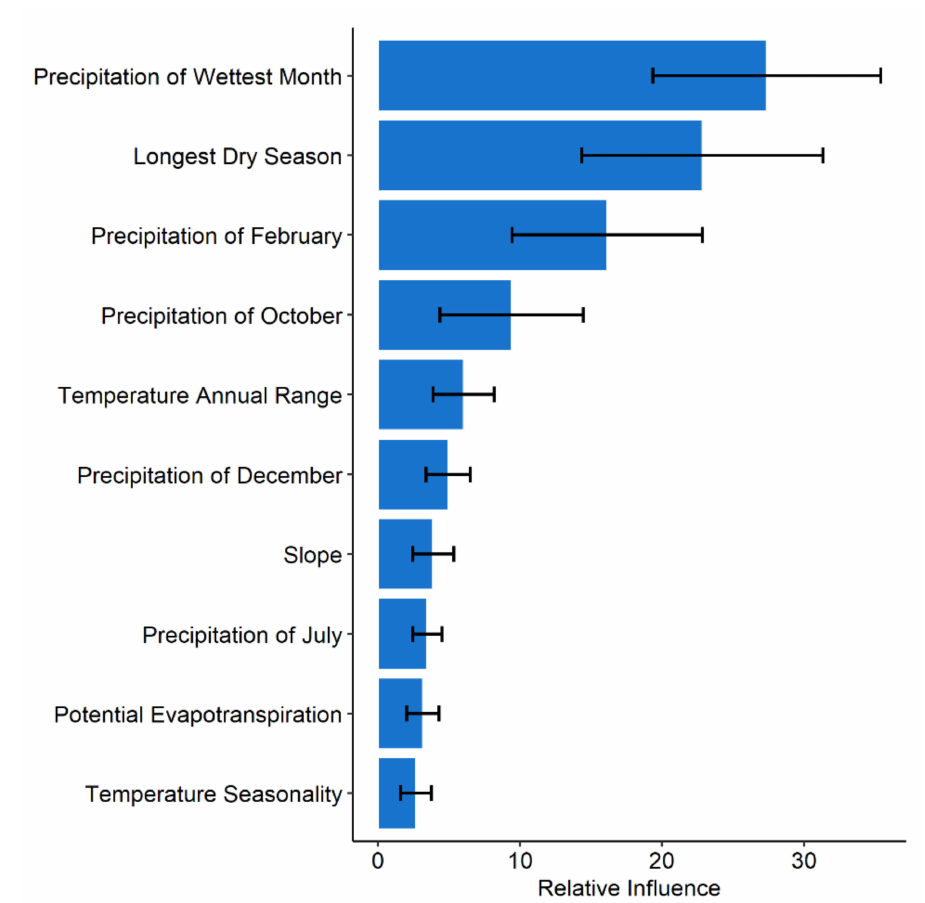
Figure 3. Variable relative influence for final variable set used to model the distribution of anthrax in Kenya using boosted regression tree experiments. Error bars represent variability across an ensemble of 100 BRT